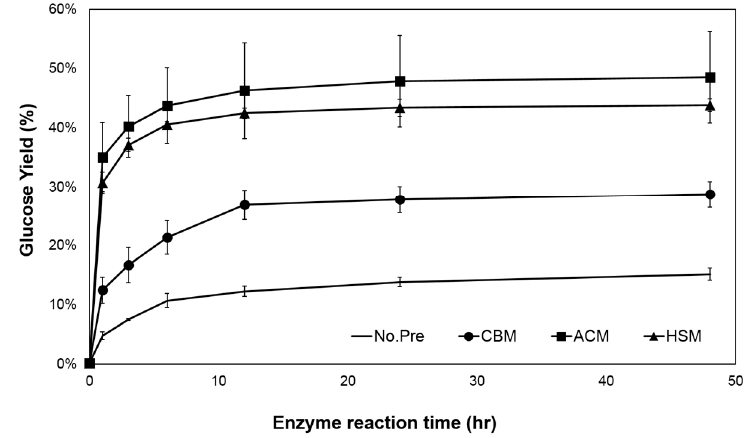
Figure 3. Glucose yields of pulverized corn stover depending on the enzyme hydrolysis time. The bars indicate standard deviation.